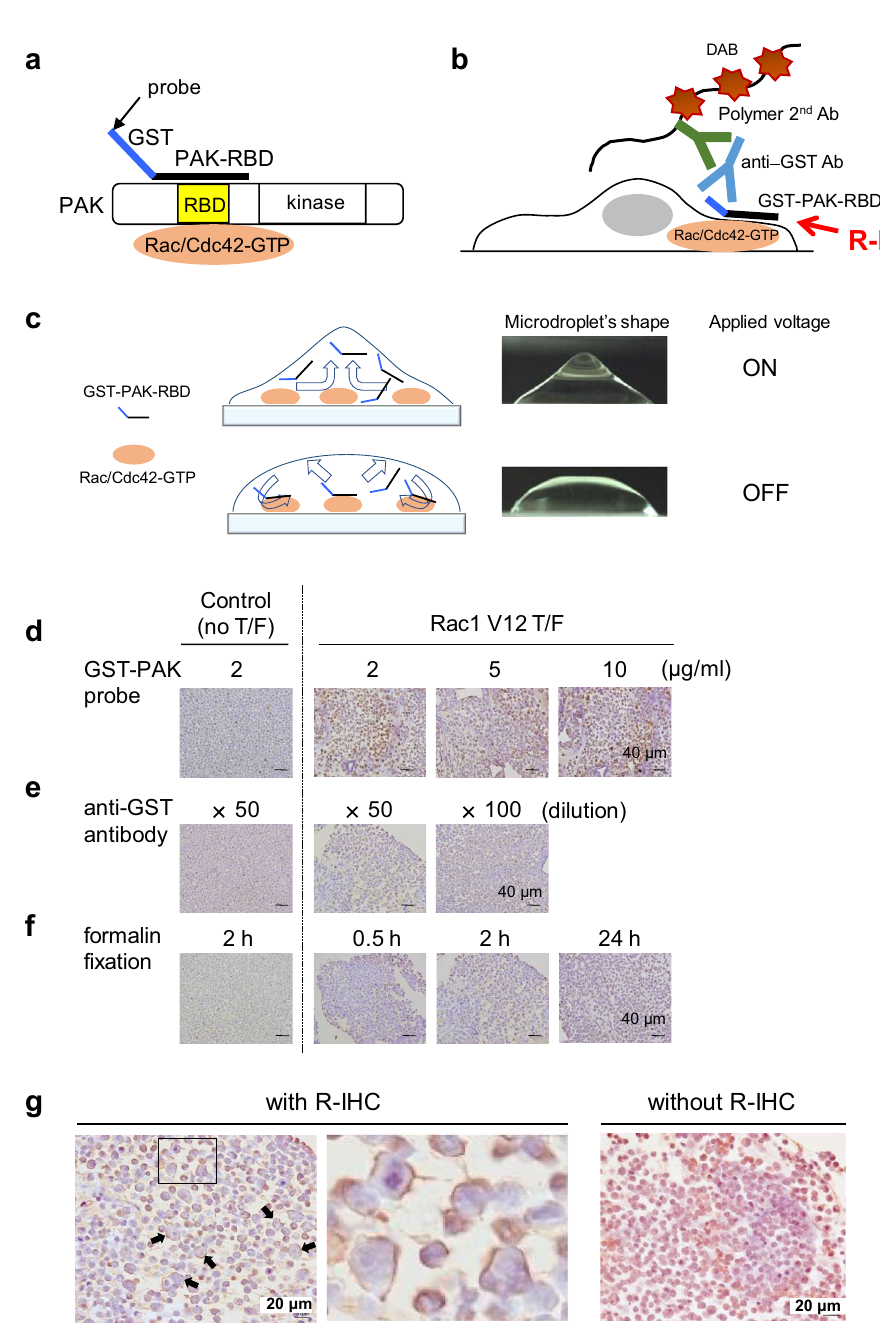
Figure 2. Staining of active Rac1/Cdc42 using a combination of GST-PAK RBD probe and R-IHC machine. ( a ) Structures of PAK protein and GST-PAK-RBD probe are displayed. ( b ) Principle of immunostaining for active Rac and Cdc42 using the GST-PAK-RBD probe on FFPE tissues. An R-IHC machine was employed to promote the reaction between Rac/Cdc42-GTP and the GST-PAK-RBD probe. ( c ) Schematic of the changes in the microdroplet as the voltage is switched on and off. The GST-PAK-RBD probes are mixed within the microdroplet. The resultant Coulomb force stirs the probe solution on the sections, and the opportunity for binding between the probe and Rac/Cdc42-GTP is increased because as the voltage is turned on and off at regular intervals, the microdroplet shape is changed. ( d – g ) Establishment of optimal staining conditions for active Rac1, rationally active Cdc42 too, in FFPE samples. A cell block from 293 T cells with Rac1V12 was utilized for the following investigations: ( d ) GST-PAK concentration (2, 5, 10 µg/ml), ( e ) dilution ratio of α-GST Ab (× 50, × 100 dilution), ( f ) formalin-fixed duration (30 min, 2 h, 1 day), and ( g ) immunostaining with or without R-IHC. In ( g ), high magnification image is shown in middle. Arrows indicate cells with enforced Rac1V12. 293T cells without transfection were used as a negative